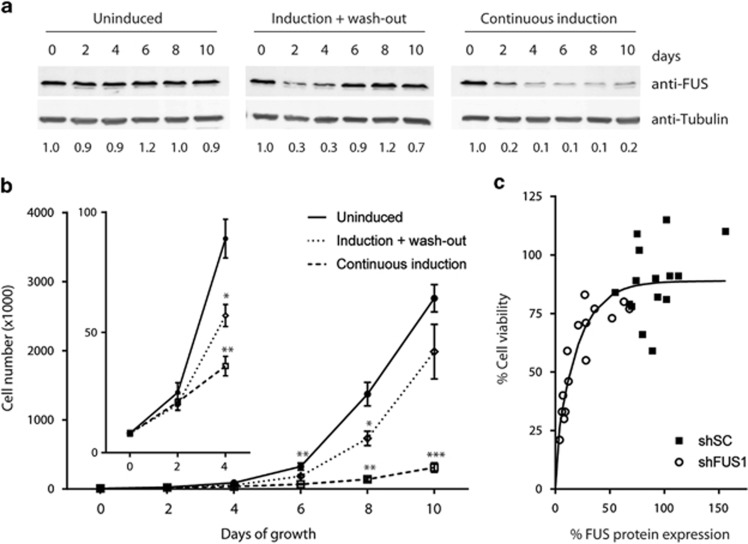
Decreased cell viability correlates with the degree of FUS knockdown. (a) NSC-34 cells expressing shFUS1 were uninduced, induced with tetracycline for 24 h after which tetracycline was removed (induction + wash-out) or subjected to continuous induction and FUS knockdown. Western blot analyses of the indicated FUS knockdown experiment reveal FUS expression is restored in the wash-out condition by day 6. Numbers below the blots refer to densitometry measurements that were normalized to ‘day 0', which represents the starting-point of the experiment. Tubulin serves as a loading control. (b) Quantification of cell number as a function of time for the indicated conditions. Cells with continuous FUS knockdown exhibited the slowest growth rate between days 2 and 4 (inset) and throughout the 10-day experiment. Upon re-expression of FUS, the growth rate for cells in the wash-out condition was accelerated and became similar to that of the uninduced condition. Data shown are the average of three independent experiments±S.E. Statistical significance was determined by a Student's t-test (*P<0.05; **P<0.01; ***P<0.001; day 6 significance is for the continuous induction condition). (c) Cell viability, as determined by the MTT assay, correlates with the level of FUS protein expression, as determined by western/densitometry analyses. Data are compiled from three independent FUS knockdown experiments, where shSC or shFUS1 was induced in NSC-34 cells for 1–5 days. An exponential fit of this data was created with GraphPad prism (La Jolla, CA, USA)